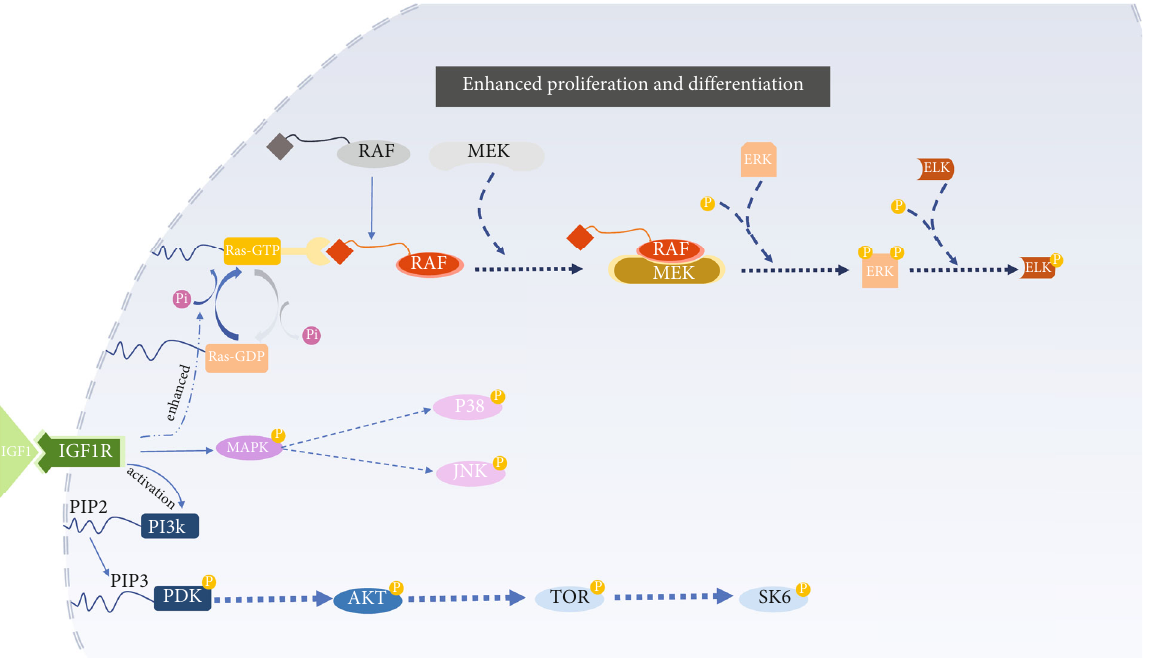
Figure 1: The postevent of IGF1 and IGF1R binding in cells. After IGF1 binds to IGF1R, two main pathways are activated. Ras-GTP expression is enhanced, leading to the activation RAF pathway, thus activating ELK and MAPK pathway. PI3K is activated, then boost AKT and mTOR